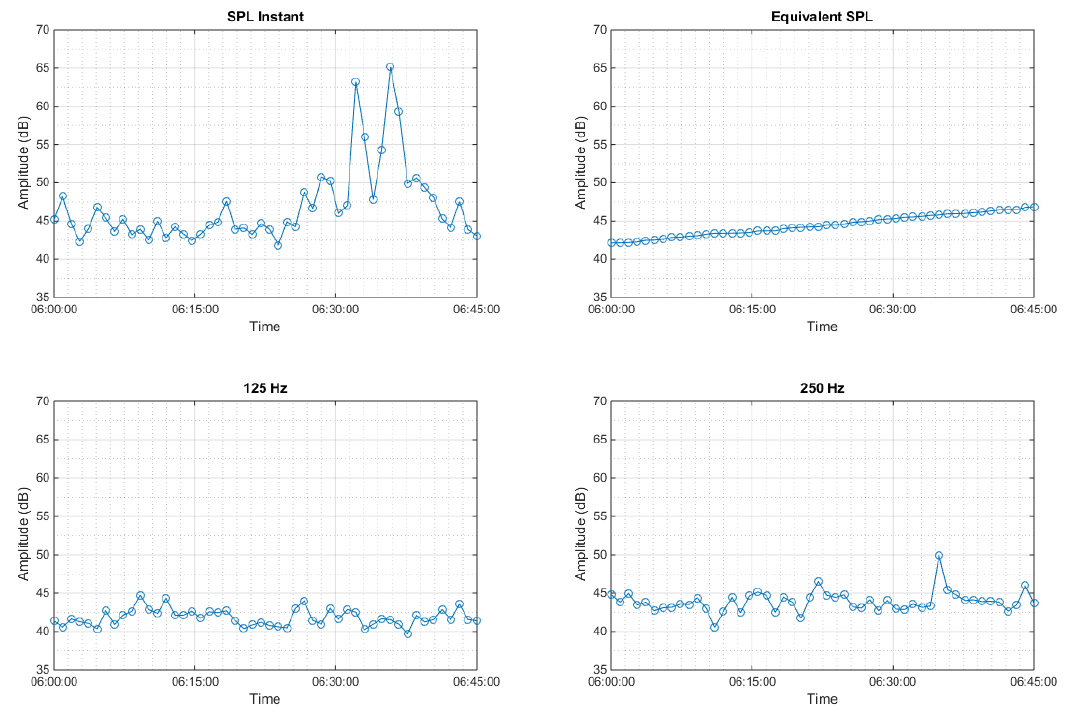
Figure 6. Views of the instant sound pressure level broadband and for 125 Hz and 250 Hz third octave bands and for the equivalent sound pressure